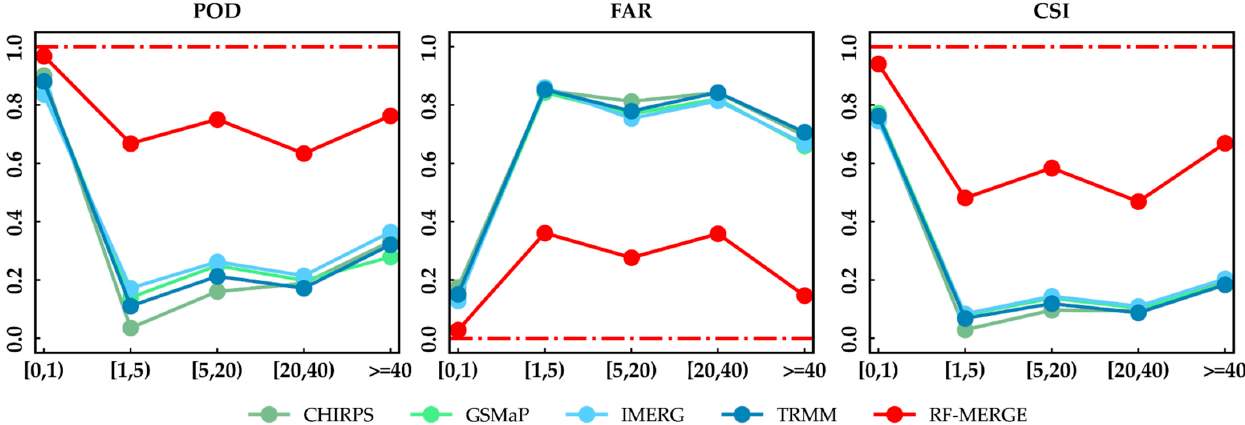
Figure 5. Categorical indices: POD, FAR, and CSI, at five precipitation intensity classes (in mm/d). The optimal value of each index is indicated by the red dashed line.